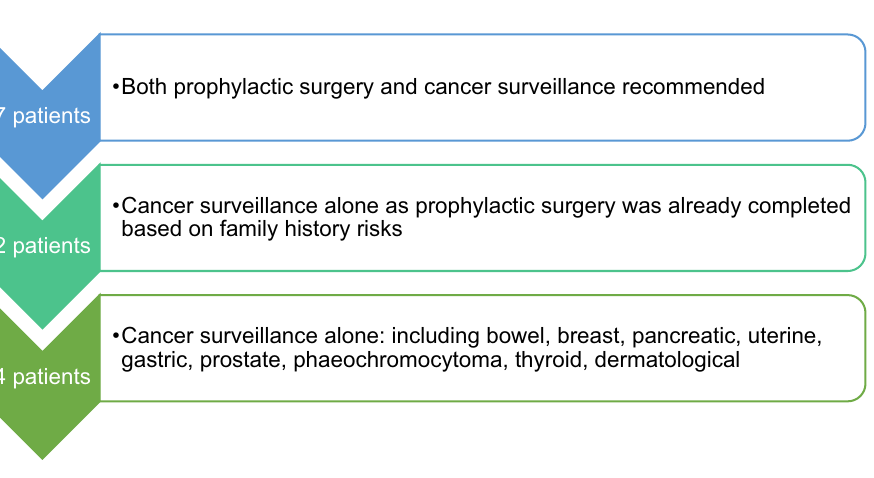
Figure 6. Actionability of gene panel results for 13